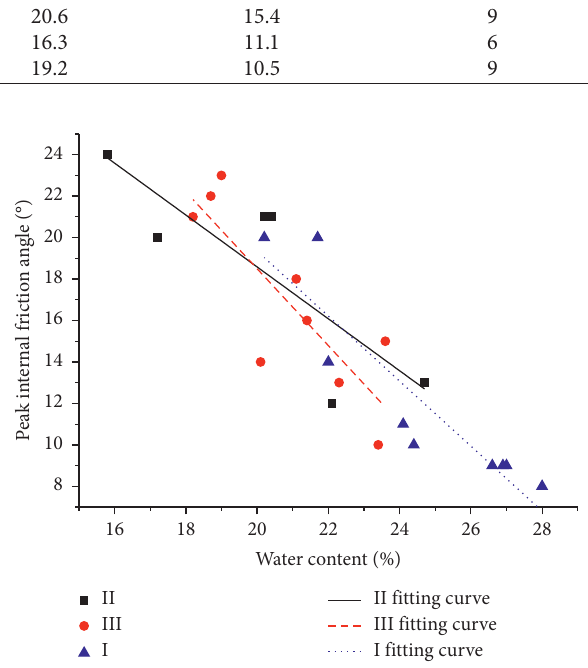
Figure 13: The curve of peak internal friction angle with moisture content